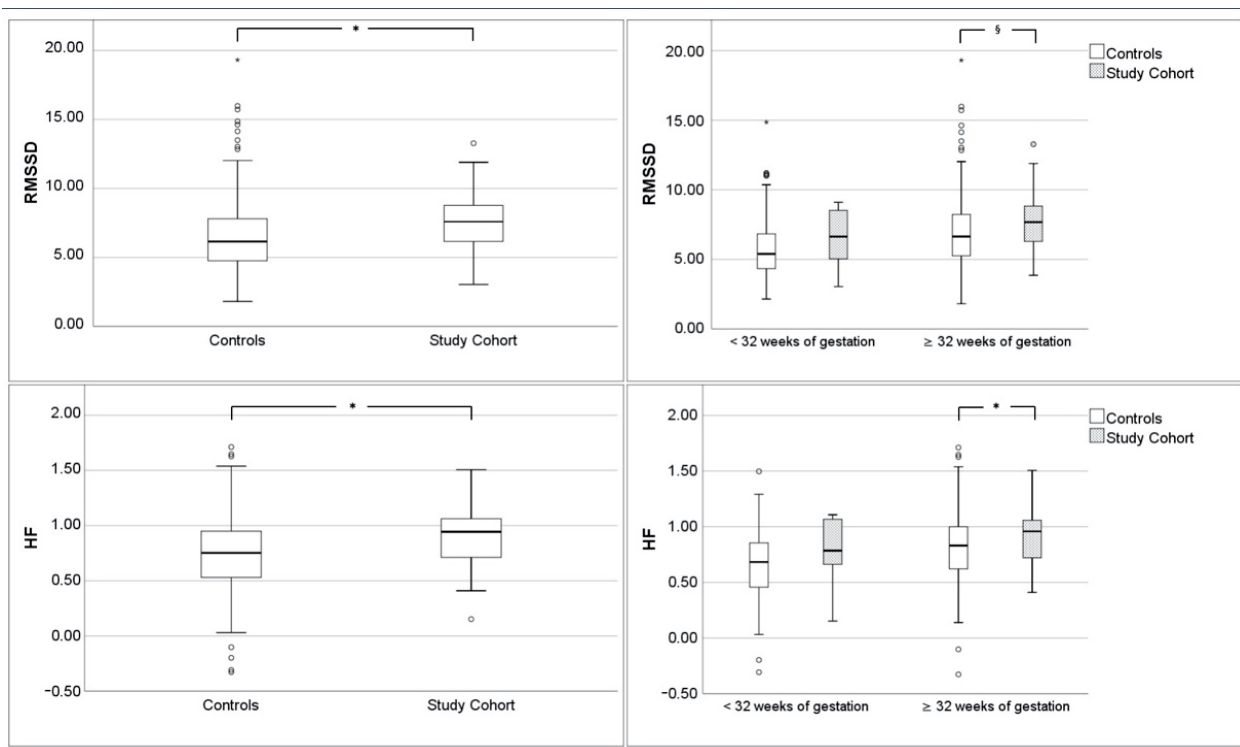
Figure 2. Boxplots of RMSSD and HF representing vagal tone over the entire gestational period (left panels) and <32/ ≥ 32 weeks of gestation (right panels) comparing study and control cohorts, ( p < 0.05 marked with *; trend p < 0.1 marked with §; t -test).